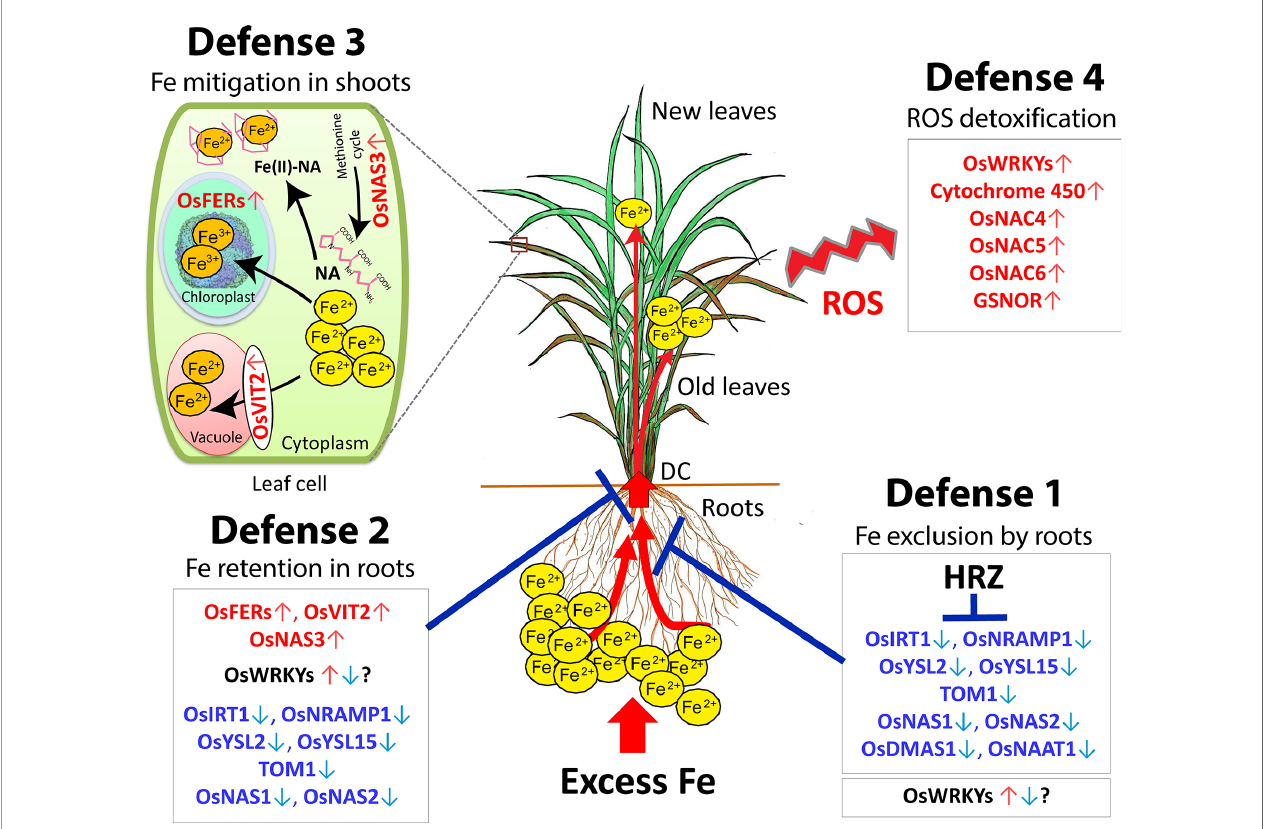
FIGURE 2 | Hypothetical model of the four defense mechanisms of rice against excess Fe. Defense 1: Fe excess tolerance by Fe exclusion in the roots. Defense 2: Fe-excess-tolerance by Fe retention in root and avoidance of Fe translocation to shoot. Defense 3: Fe excess tolerance by Fe compartmentalization in the shoot. Defense 4: Fe excess tolerance by ROS detoxi fi cation in the plant. DC, Discrimination center; NA, nicotinamine. Red letters, highly induced genes; Blue letters, highly suppressed genes. This fi gure is modi fi ed from the Supplemental fi gure of Aung et al., 2018b. The ferritin image was provided by Dr. David S. Goodsell (Scripps Research Institute, La Jolla, CA) and the RCSB